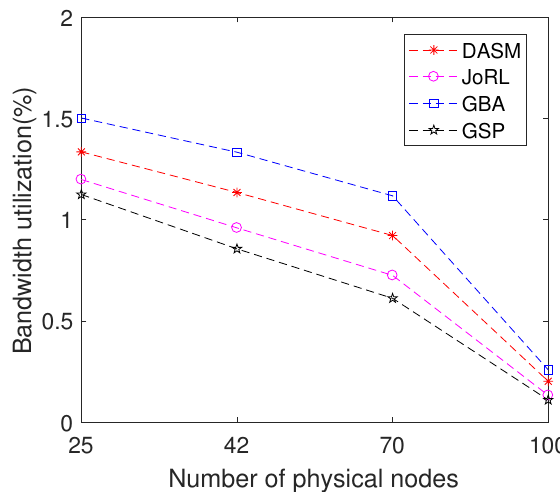
Figure 10. Bandwidth consumption